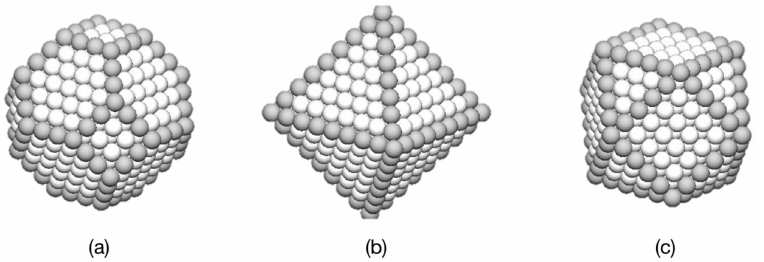
Figure 8. Equilibrium and “close to equilibrium” morphologies for nanoparticles of fcc metals. ( a ) A 586-atom polyhedron conforming to the Wulff construction. ( b ) A 489-atom octahedron containing only (111) faces. ( c ) A 561-atom cuboctahedron produced by truncating an octahedron by a cube. Reproduced with permission from [5].